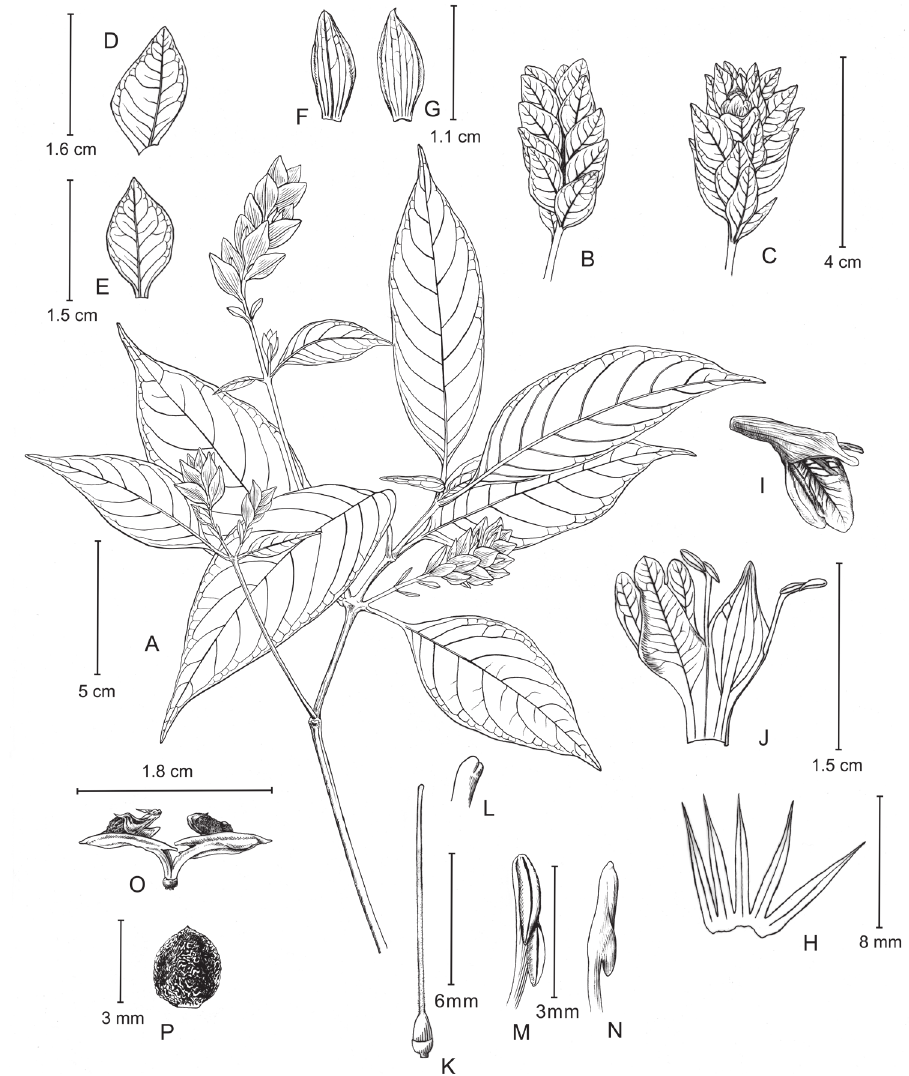
Figure 3. Line drawings of Rungia fangdingiana sp. nov. A flowering branch B spike (abaxial view show- ing the sterile bracts) C spike (adaxial view showing the fertile bracts and corolla) D sterile bract E fertile bract F bracteole (abaxial view) G bracteole (adaxial view) H calyx I corolla J opened corolla K pistil L stigma M stamen (adaxial view) N stamen (abaxial view) O dehiscent capsule (showing the rising pla- centa and seeds) P seed. Drawn by Yun-Xiao